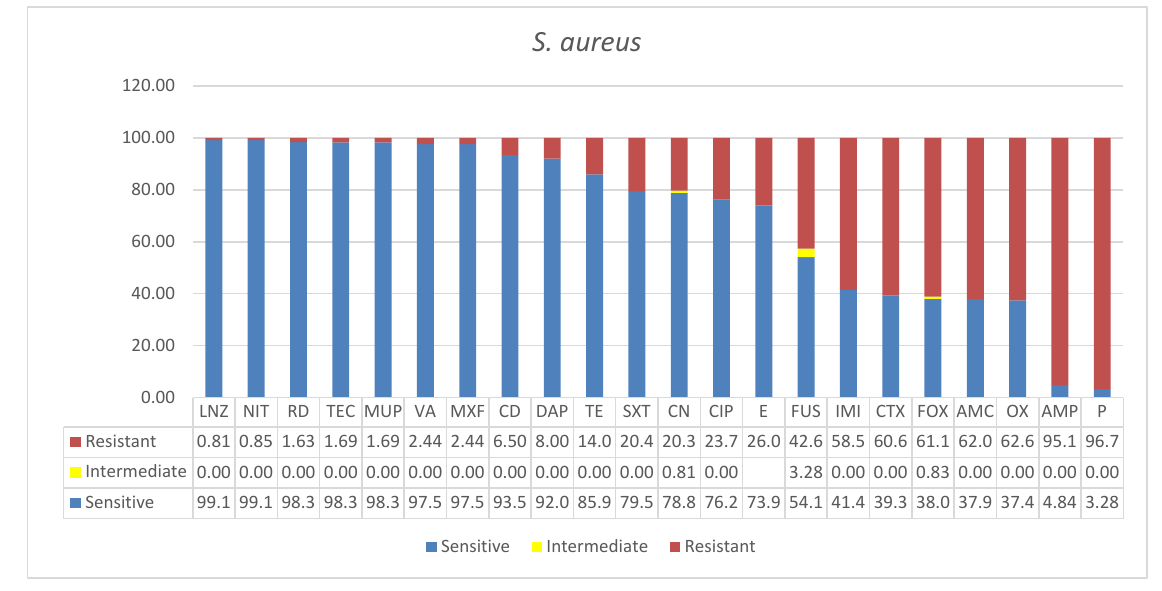
Figure 1. Antimicrobial sensitivity patterns of S. aureus isolates to 22 antibiotics. Abbreviations (in the order in which they appear in the figure): LNZ linezolid, NIT nitrofuran, RD rifampicin, TEC teicoplanin, MUP mupirocin, VA vancomycin, MXF moxifloxacin, CD clindamycin, DAP dapto- mycin, TE tetracycline, SXT trimethoprim*/sulfamethoxazole, CN gentamicin, CIP ciprofloxacin, ERY erythromycin, FUS fusidic acid, IMI imipenem, cefotaxime CTX, cefoxitin FOX, AMC AMPI- CILLIN*/SULBACTAM, OX oxacillin, AMP ampicillin, P